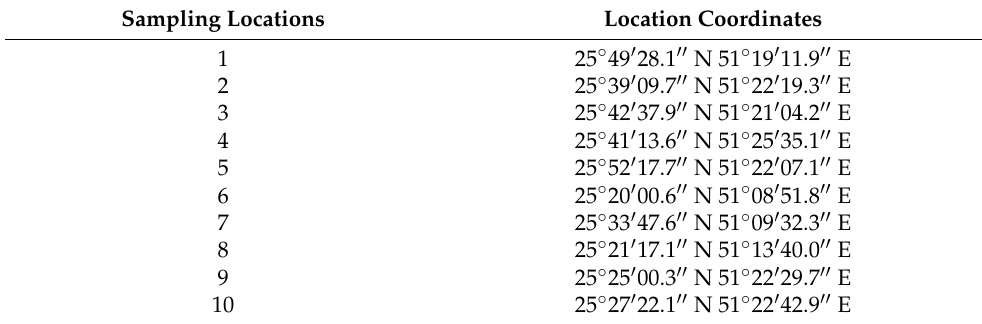
Table 1. Sampling locations and their corresponding coordinates. Sampling